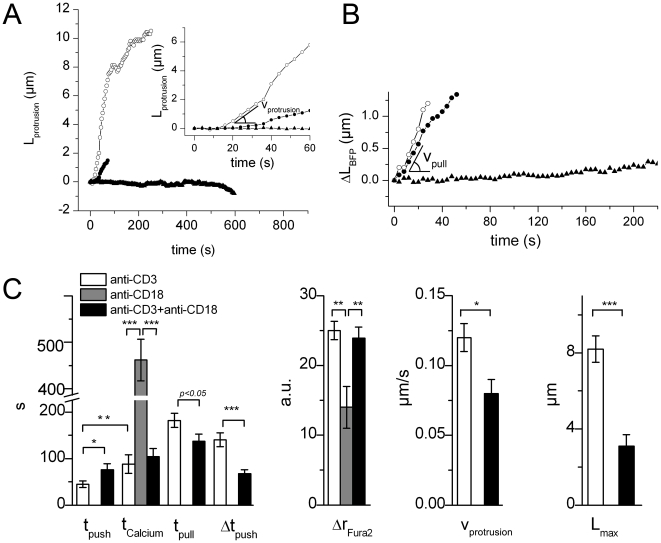
Reduced CD3-Dependent Force Generation upon CD18
Engagement.(A) Lprotrusion versus time for anti-CD3 coated beads
(open circles), anti-CD3+anti-CD18 coated beads (full circles),
and anti-CD18 coated beads (full triangles). The co-engagement of
both CD3 and CD18 reduces vprotrusion, while CD18-only
engagement abolishes protrusion growth. Inset shows the beginning of
the growth. (B) BFP elongation ΔLBFP versus time, for
anti-CD3 coated beads (open circles), anti-CD3+anti-CD18 coated
beads (full circles), and anti-CD18 coated beads (full triangles).
(C) Comparison of outcome upon CD3-, CD3+CD18- and
CD18-engagement when T cells interact with the BFP. We compare times
(t = 0 when the bead contacts the T cell)
tpush (start of the pushing phase),
tCalcium
([Ca2+]i increase time),
tpull (start of pulling phase), and duration of the
pushing phase
Δtpush = tpull−tpush.
We also compare the Calcium response amplitude (fura2 ratio
ΔrFura2), pushing speed vpull and
maximal protrusion length Lmax
(*p<0.01, **p<0.001,
***p<0.0001).